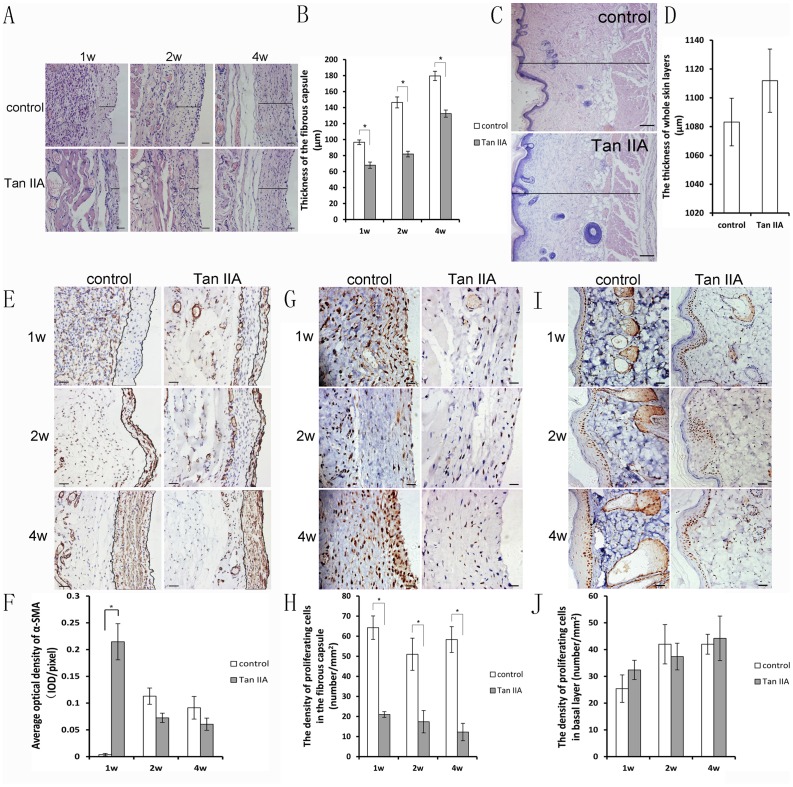
The thickness of the fibrous capsule in the Tan IIA group was much less than that in the control group at all of the time points (A and B), and the thickness of the whole skin layers, except the fibrous capsule, showed no difference (C and D).There were fewer α-SMA positive myofibroblasts in the fibrous capsule in the Tan IIA group (E and F), and their proliferation was much lower (G and H). The proliferating cells in the basal layer in the two groups showed no difference (I and J). The area within the black lines in E was calculated for the α-SMA density. The scale bars in E, G and I were ×200. Mean ± SD; *P<0.05; Bar in C, 40 µm; Bar in E, G, and I, 200 µm.